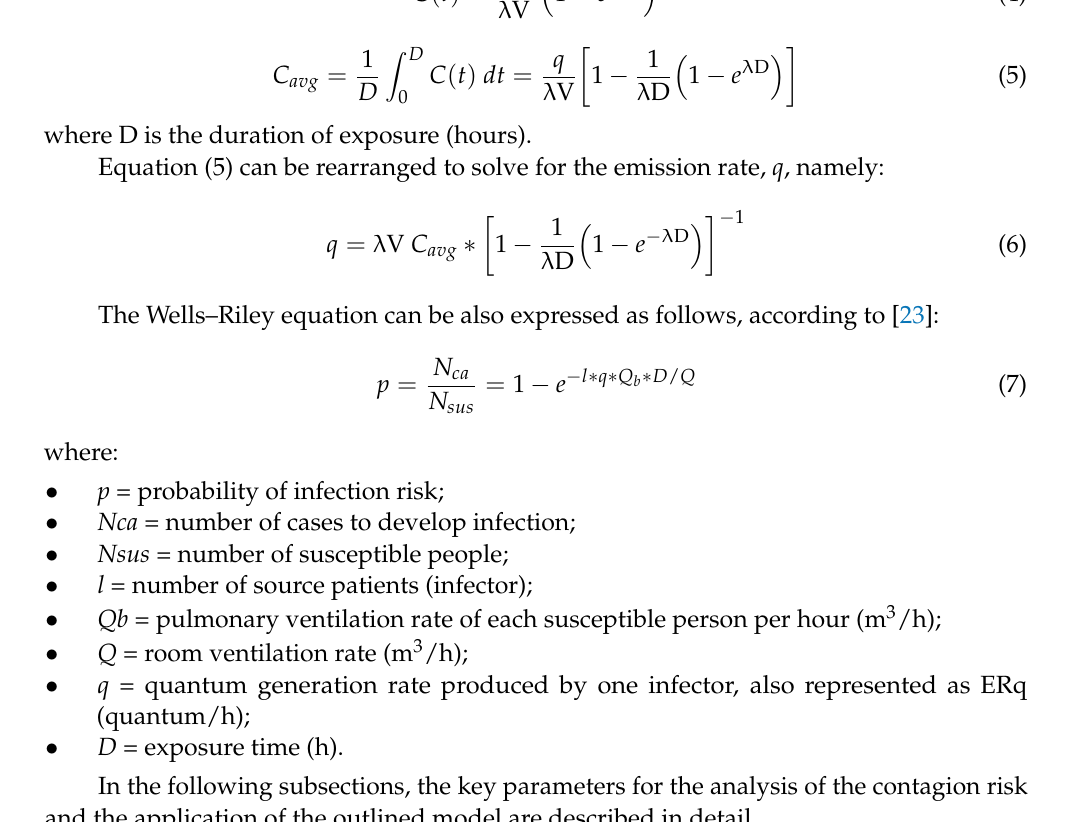
Table 1. Quanta emission rates for SARS-CoV-2 (quanta/hour). Activity Oral Breathing Speaking Sedentary/Passive